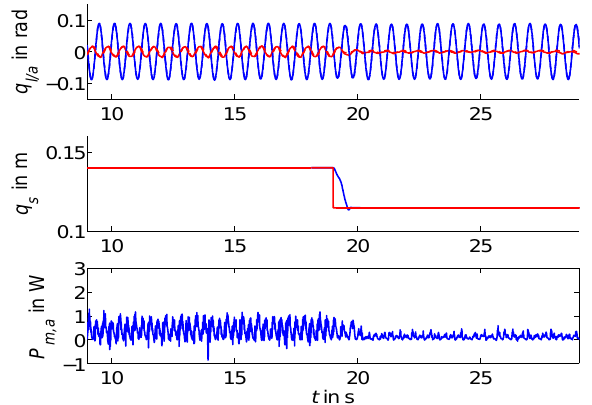
Figure 9. Adjustment to antiresonance while tracking a sinusoidal trajectory with 1.6Hz; link (blue) and actuator (red) positions in upper plot, desired (red) and current (blue) counter bearing positions middle plot, mechanical power in lower plot.